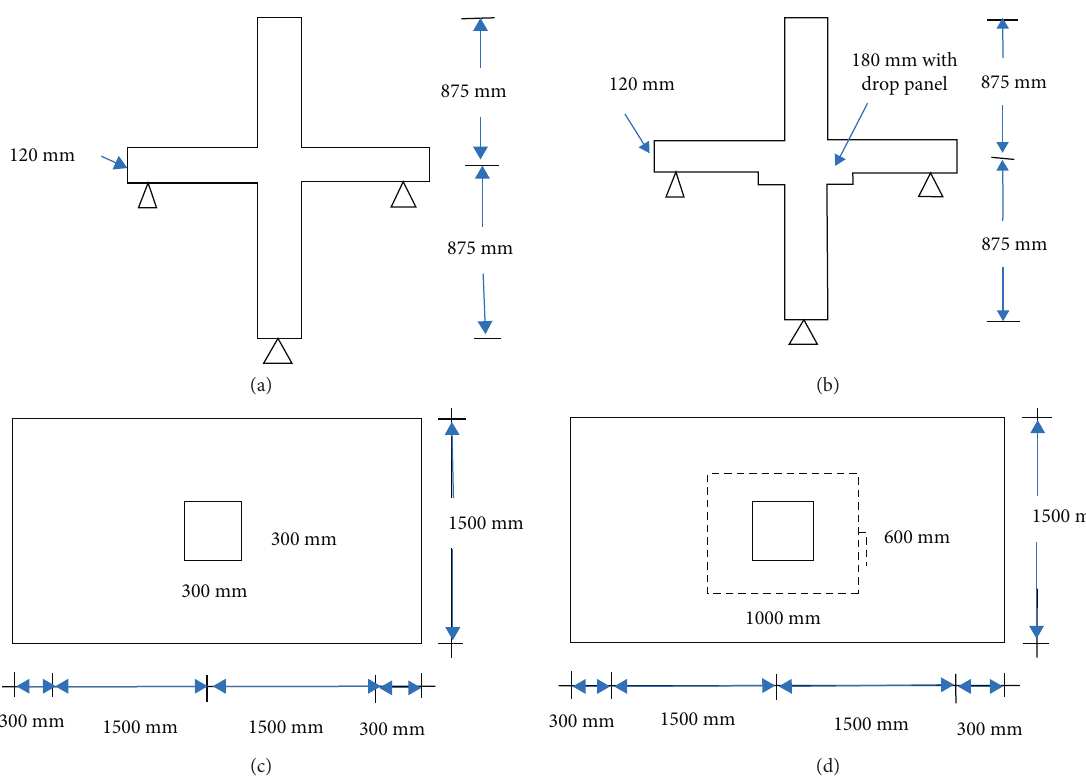
Figure 4: Geometric dimension of the model specimens. (a) Side view without drop panel. (b) Side view with drop panel. (c) Top view without drop panel. (d) Top view with drop panel.